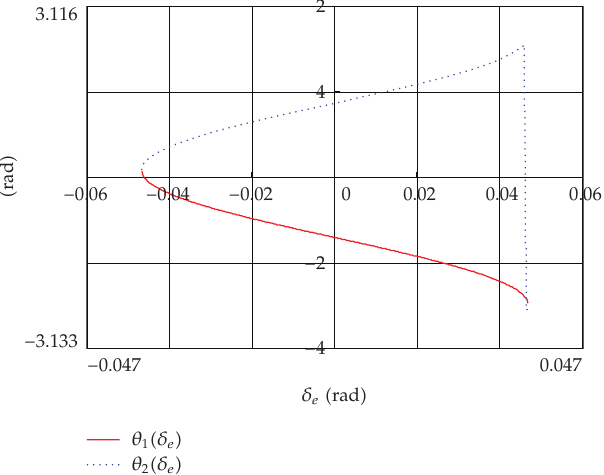
Figure 2: The θ 1 (cid:3) δ e (cid:4) (cid:8) 2 kπ and θ 2 (cid:3) δ e (cid:4) (cid:8) 2 kπ coordinates of the equilibriums on the manifold M V